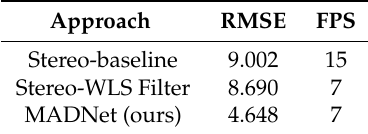
Table 4. Experimental results of stereoscopic approaches compared to our proposal based